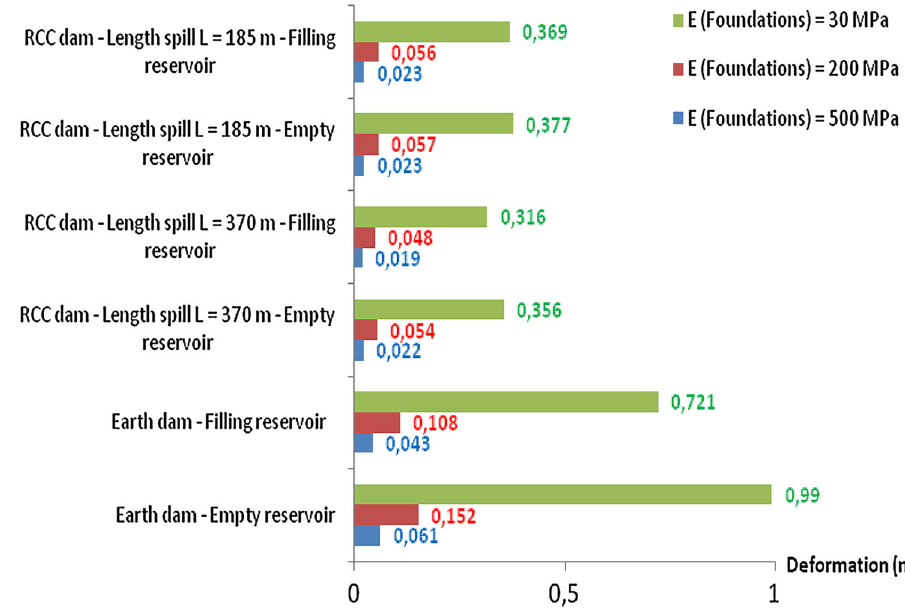
Fig. 8 Summary of